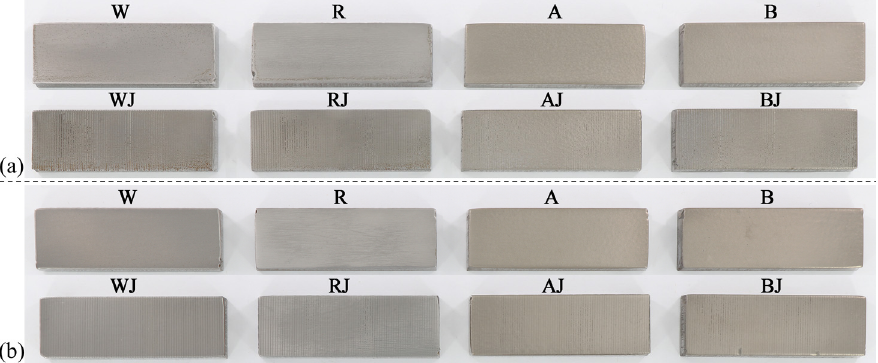
Figure 11. Specimens after the abrasion at the relative sliding speeds of 2.35 m/s ( a ) and 3.02 m/s ( b ).